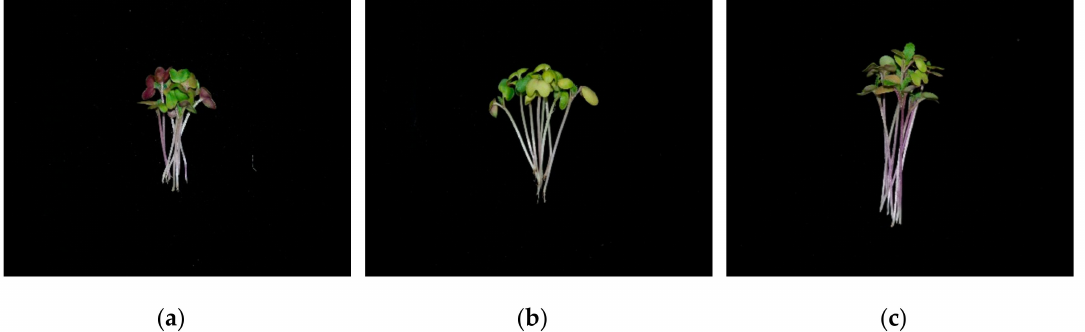
Figure 1. B. juncea sprouts grown under di ff erent LED lights (blue, white, and red) for three weeks. ( a ) Sprouts grown under white LED light, ( b ) red LED light, and ( c ) blue LED